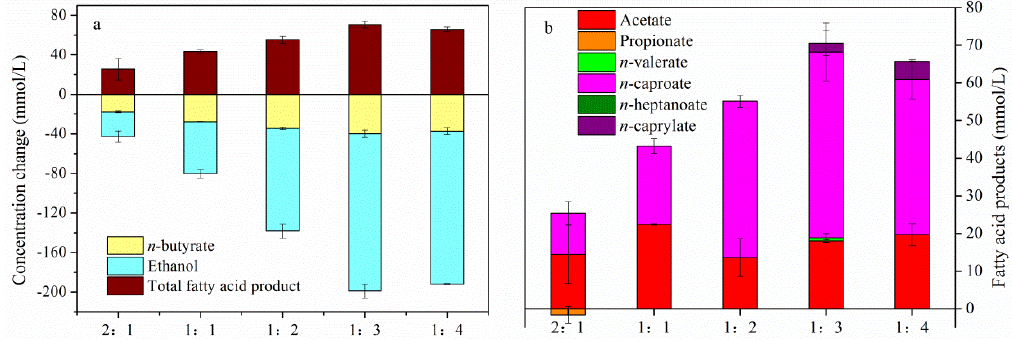
Figure 6. Substrate consumption (negative values) and product formation (positive values) ( a ) and fatty acid product distribution ( b ) with n -butyrate as the electron acceptor under the maximum reaction degree.